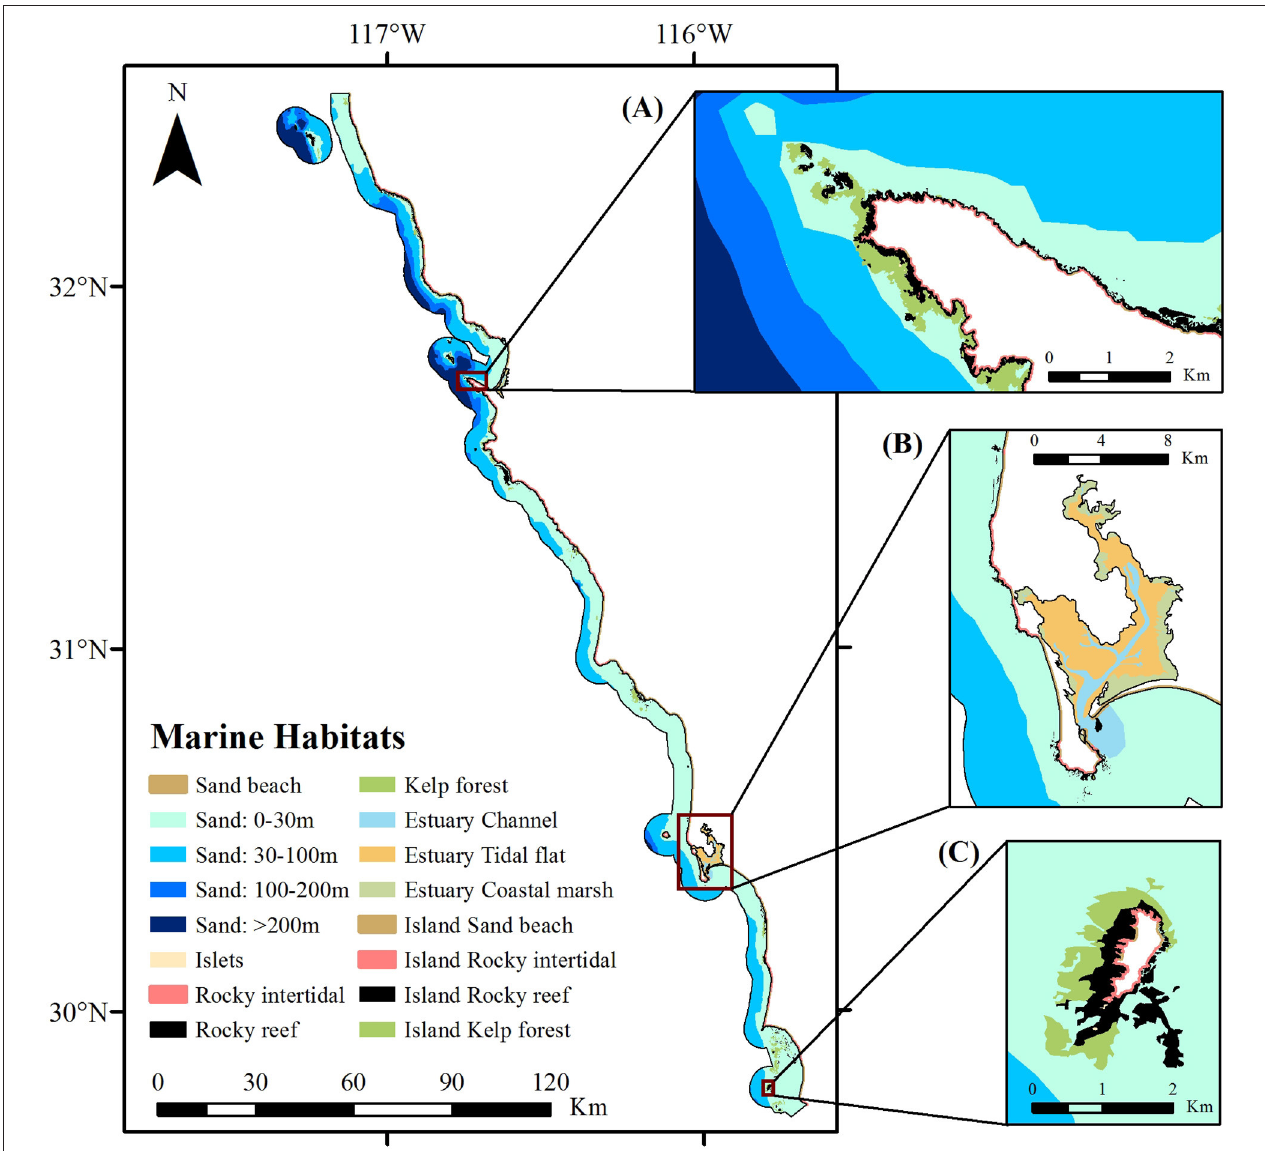
FIGURE 2 | Marine key habitat distribution from intertidal to subtidal from the MPRC1, Baja California, Mexico. Close up images show examples of: (A) Continent, (B) Estuary, and (C) Island.